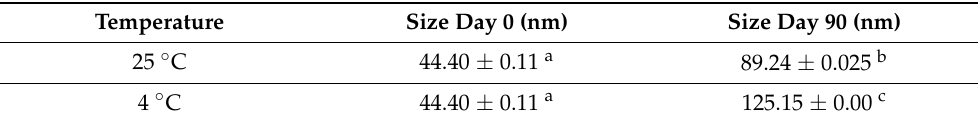
Table 1. Stability study of NE-FLO at different storage temperatures assessed using size analysis at different storage times.